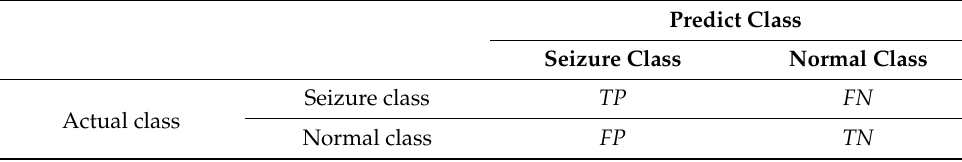
Table 3. Confusion